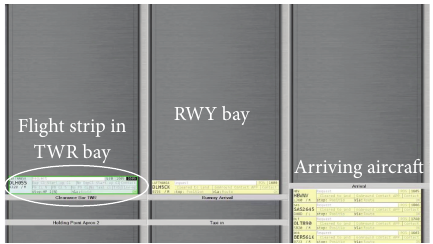
Figure 14: Electronic flight strips (smartStrips by Frequentis AG). The electronic flight strips are dynamically generated and updated according to the progress of the simulation. Flight strips are placed in different bays according to controller responsibility. The bay configurationdisplayedintheimageisusedbythe tower (TWR)and ground (RWY) controller. The tool uses the X23 SWIM interface to connect to the simulation.